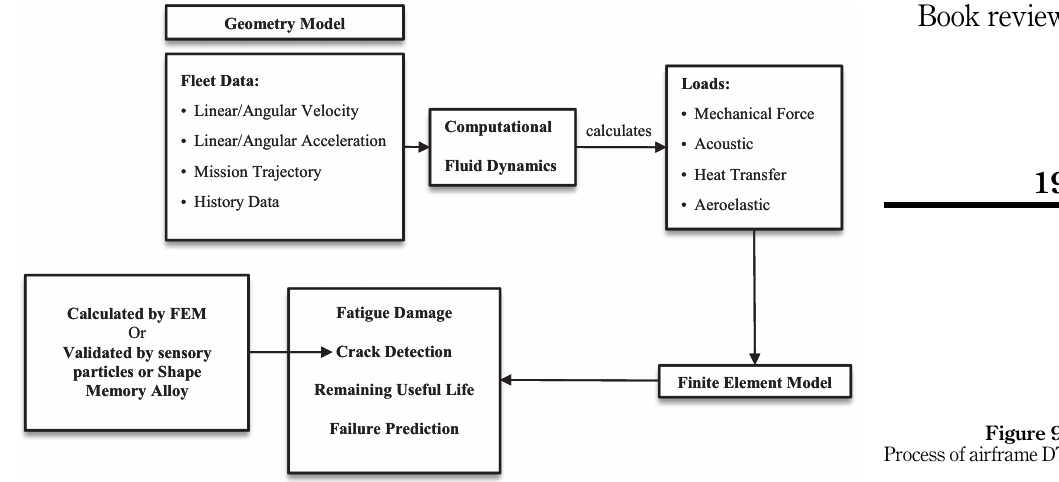
Figure 9. Process of airframe